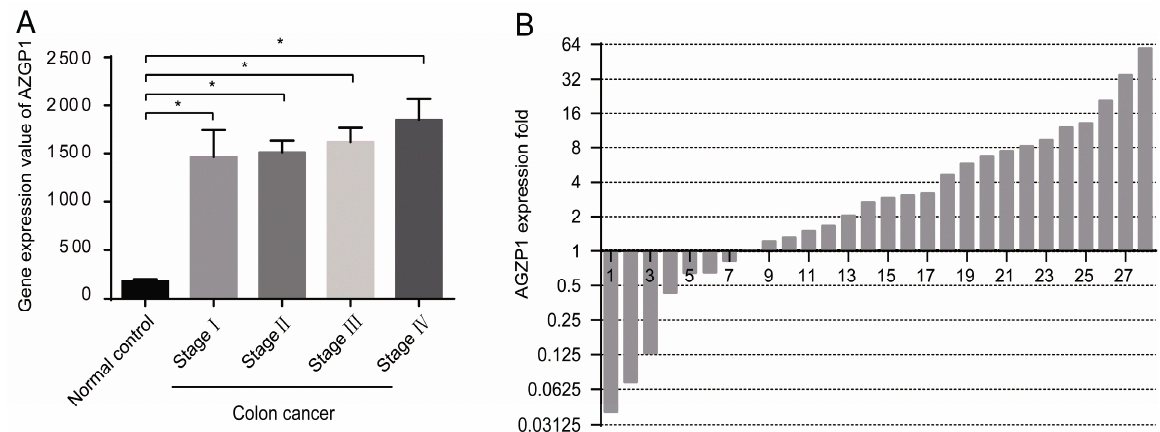
Figure 1. AZGP1 expression in colon cancer at the transcriptional level. ( A )